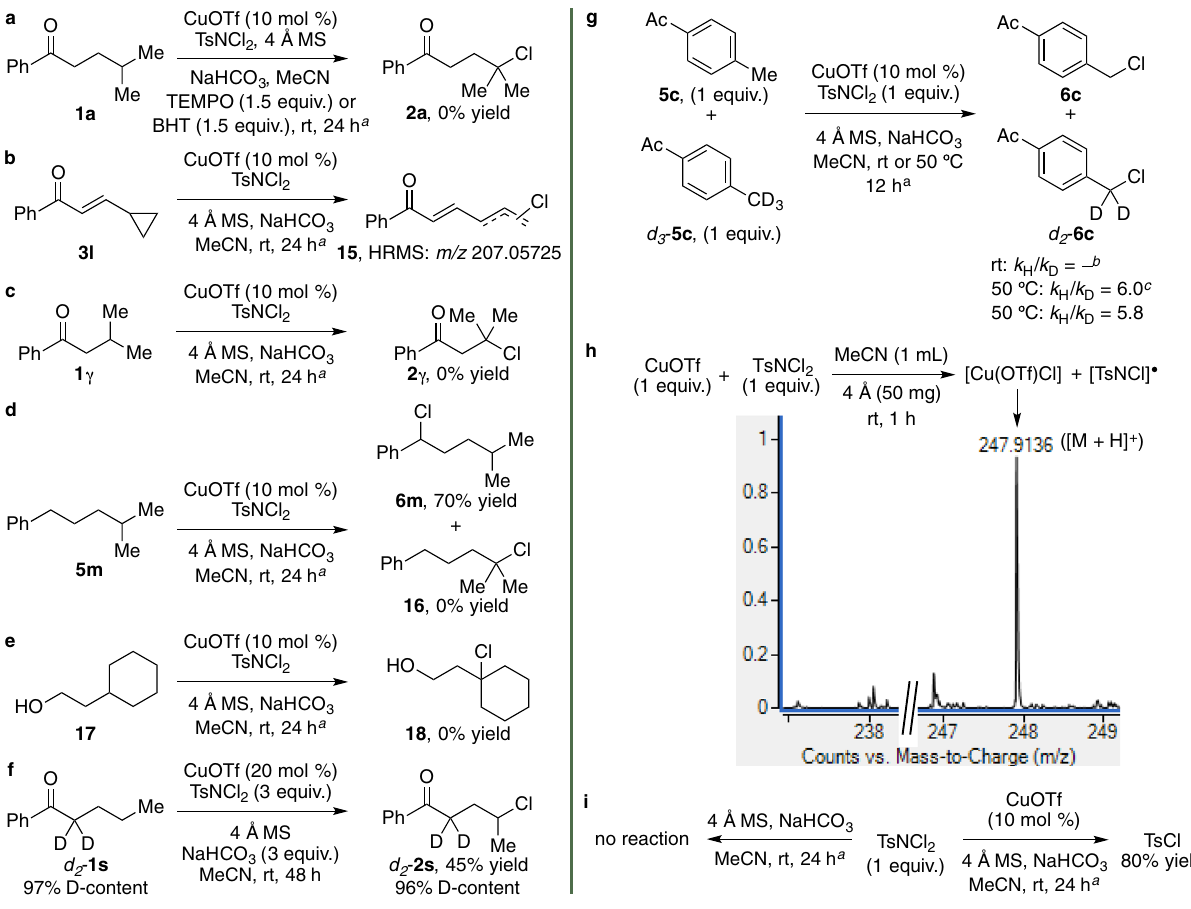
Fig. 3 Control experiments. a In fl uence of the radical scavengers TEMPO and BHT on the reaction of 1a . b Radical clock experiment with 3l . c – e Determining the role of the carbonyl functionality in the substrate with reactions of 1 γ , 5m and 17 . f Determining the possibility of an α -HAT reaction/ 1,3-H • atom shift pathway with the reaction of d 2 - 1s . g KIE measurements with 5c and d 3 - 5c . h , i Detection of the possible copper species generated from the reaction of CuOTf and dichloramine-T by HRMS measurements and reaction products obtained. a Unless otherwise stated, control reactions were performed with 1.5 equiv. of dichloramine-T, 50 mg of 4 Å MS and 1.5 equiv. of NaHCO 3 in acetonitrile (1 mL). b In parallel and competitive KIE experiments at room temperature both gave 6c as the only product in 32% yield. c In parallel KIE experiments at 50 °C afforded 6c and d 2 - 6c in 36 and 6%